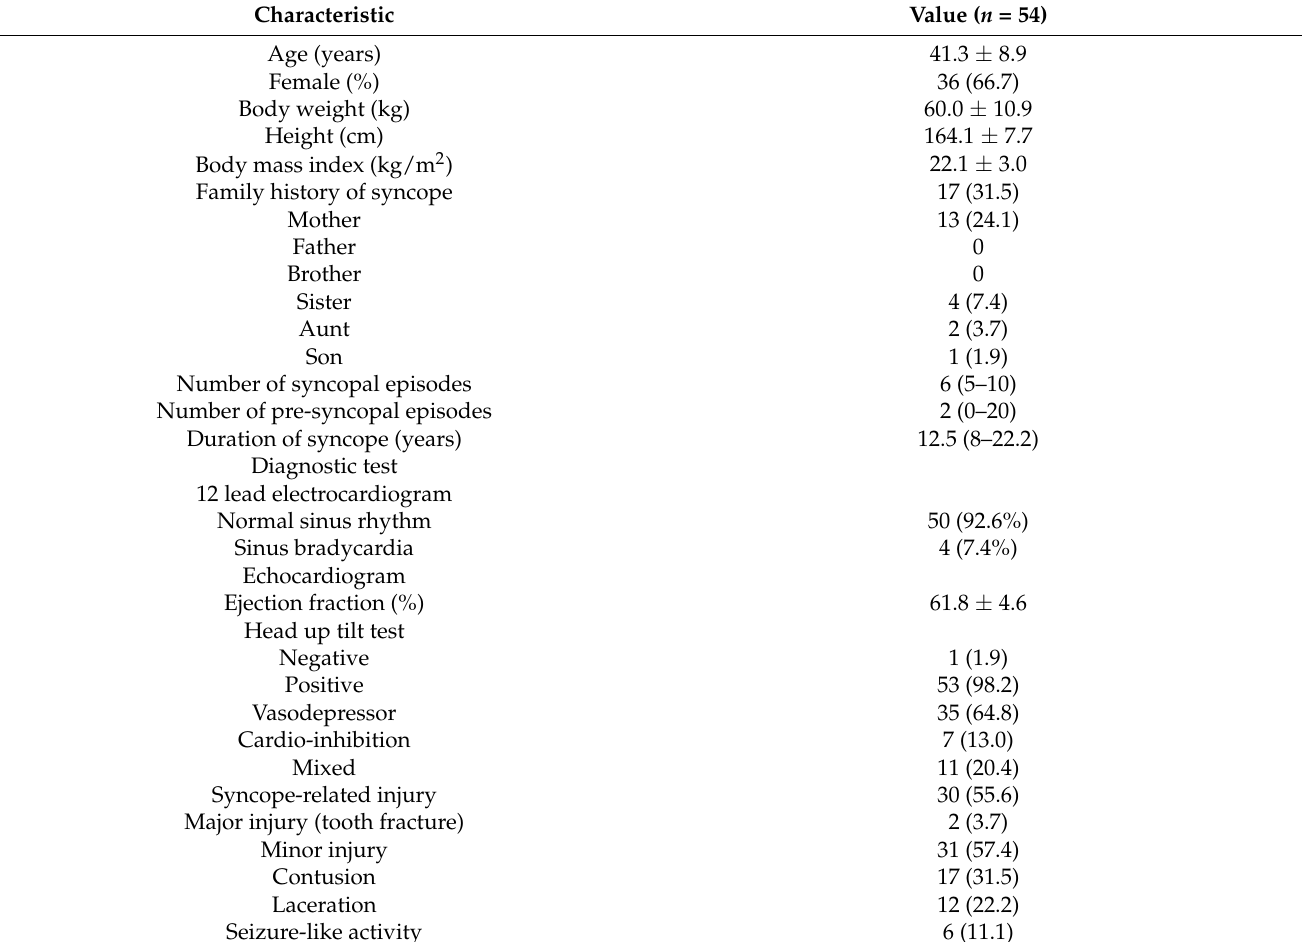
Table 2. Baseline characteristics of the study population.